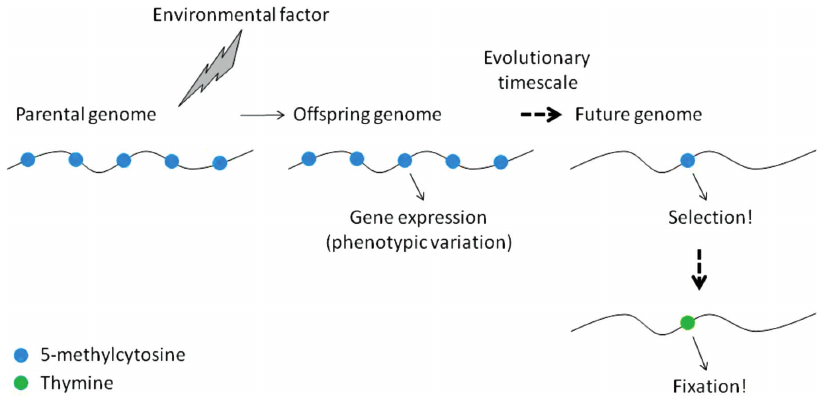
Figure 4: Evolutionary significance of epigenetic inheritance. Available empirical evidence and theoretical considerations for potential implication of epigenetic inheritance in evolution are outlined. Note that epigenetic modification may lead to genetic variation in due course.